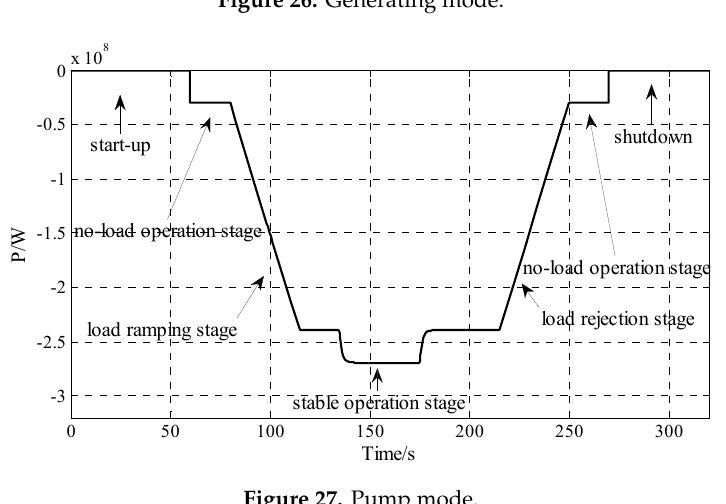
Figure 27. Pump mode.